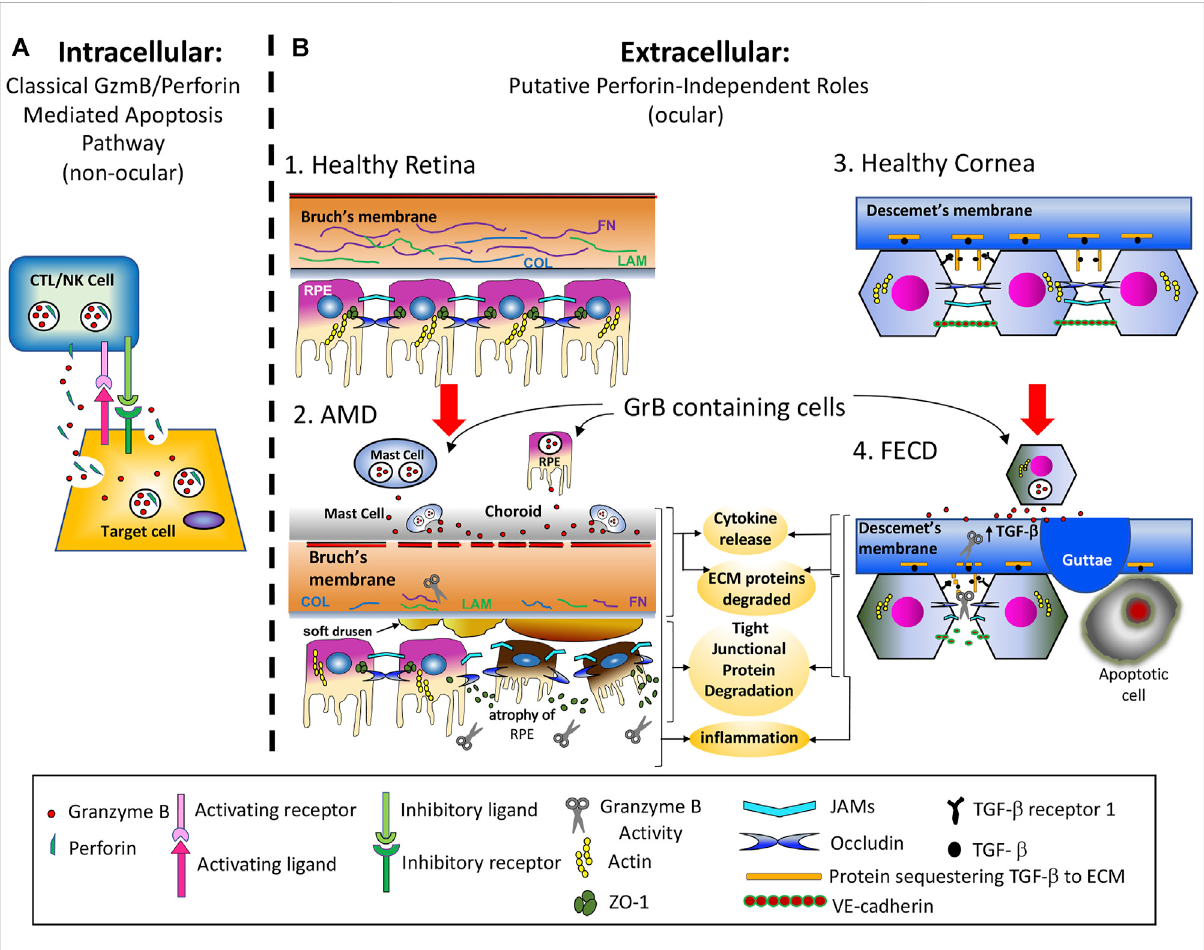
FIGURE 3 Intracellularvs.ExtracellularFunctionsofGrB. (A) .GrB ’